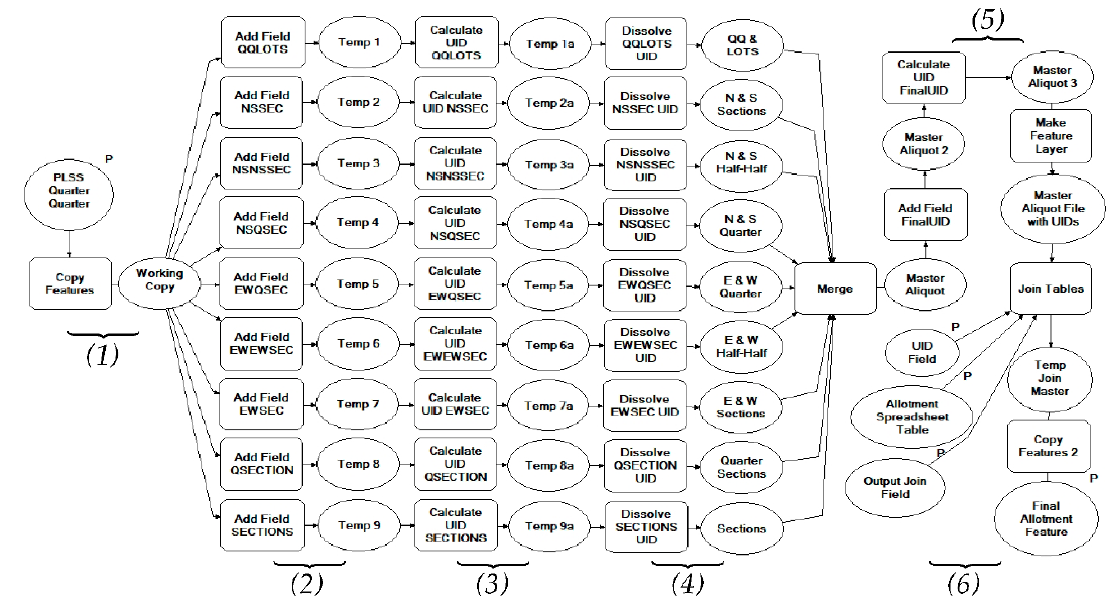
Figure 4. Schematic summary of the allotment mapping tool in ArcGIS ModelBuilder. Allotment mapping can be performed using simple and commonly available GIS processes. Step (1) create a copy of the original PLSS quarter-quarter data files. Step (2) generate new attributes fields for each class of land aliquot. Step (3) calculate the unique ID values for each type of land class. Step (4) dissolve borders of PLSS base layer polygons based on common unique ID, creating new shapes for each aliquot. Step (5) merges and concatenates the “master aliquot” file and its attributes. Step (6) joins the “master aliquot” with the tabular data of land descriptions generating the final data layer.